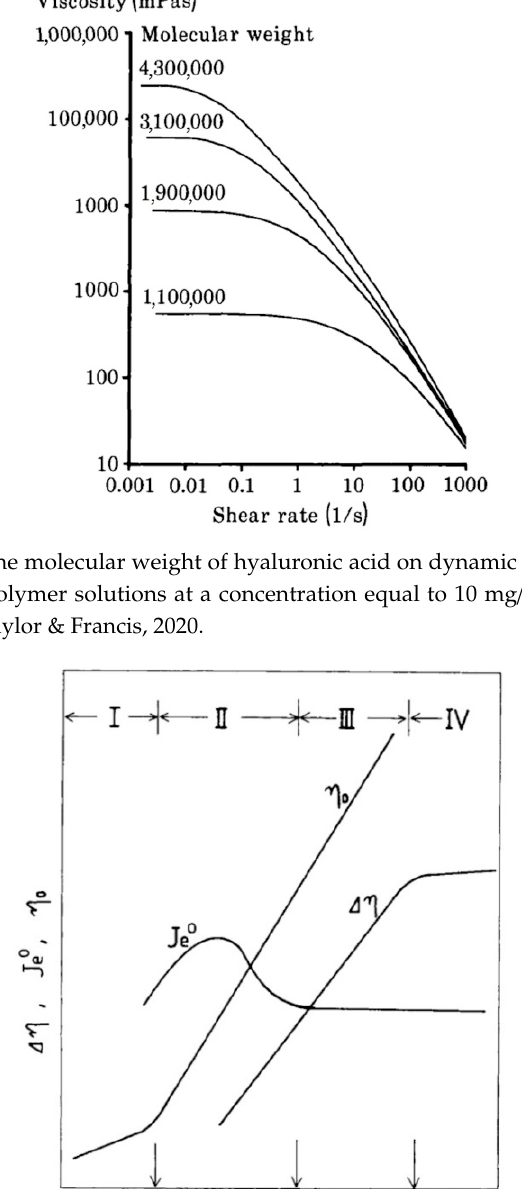
Figure 6. The effect of the molecular weight of hyaluronic acid on dynamic viscosity depending on the shear rate for the polymer solutions at a concentration equal to 10 mg/mL Adapted from [50], with permission from Taylor & Francis, 2020.